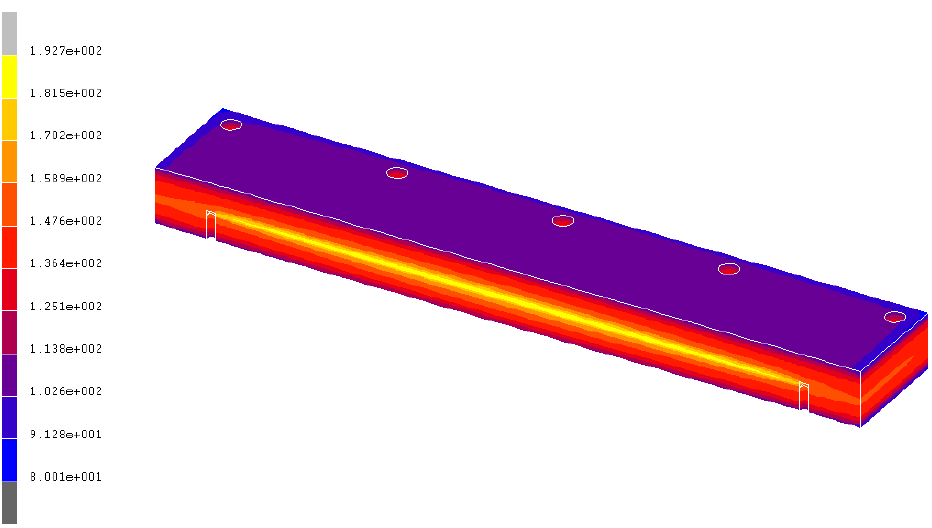
Figure 14. Temperature (°C) distribution at the end of the RTM process.